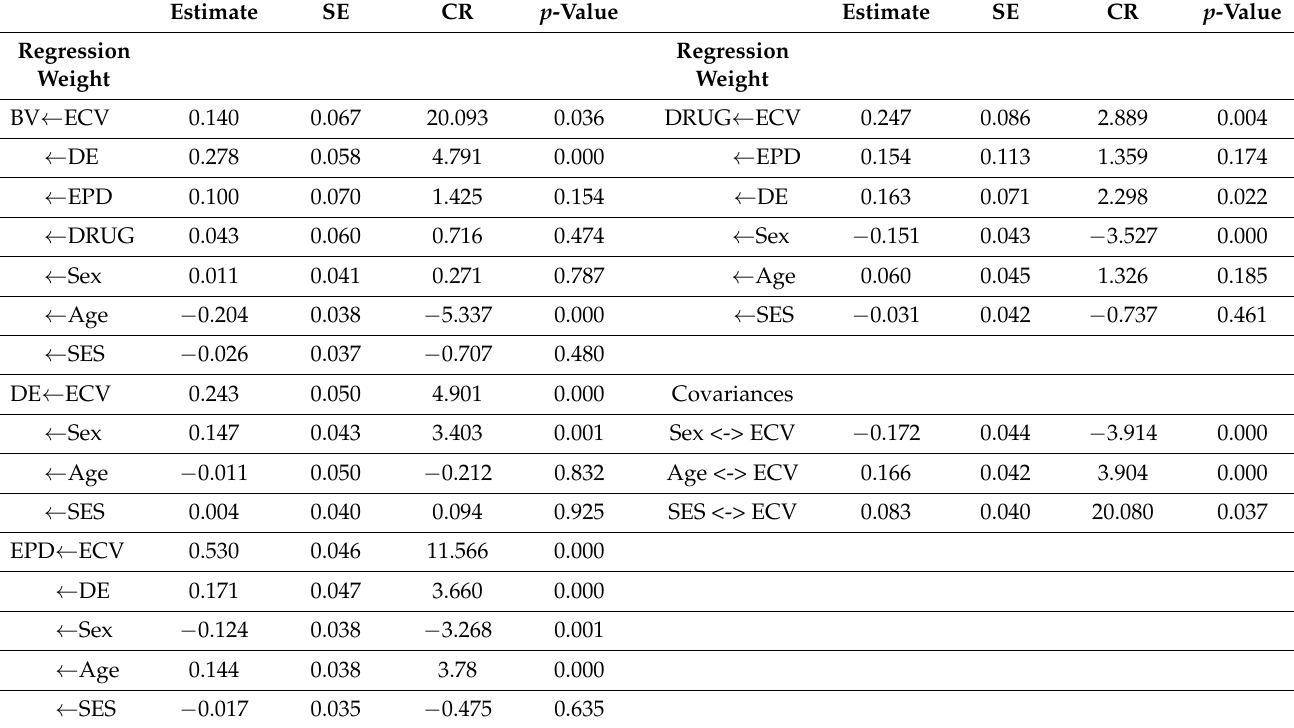
Table 2. Estimated Direct Effects and